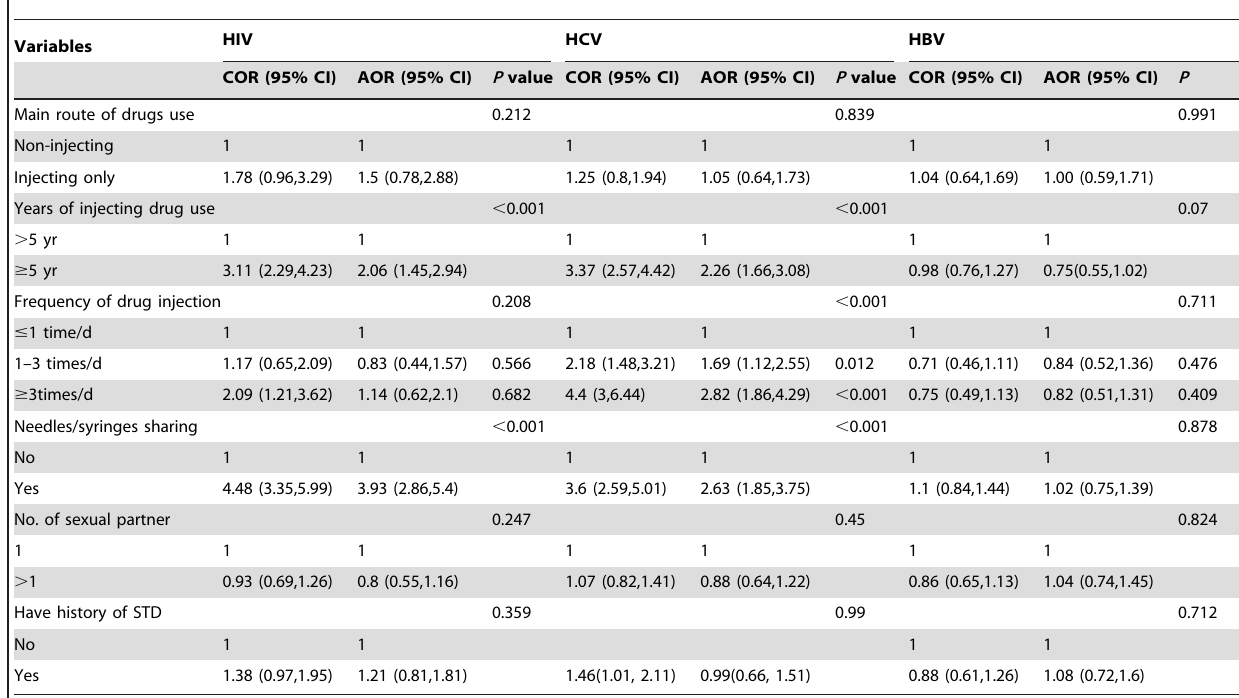
Table 4. Risk behaviors associated with HIV, HCV and HBV infection in study population in logistic regression*.